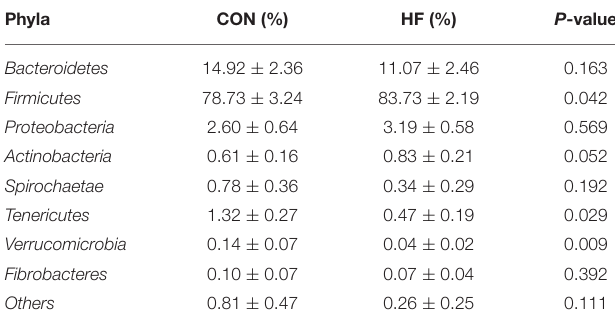
TABLE 6 | Effects of honeycomb flavonoids (0.5% of HF) on the relative abundances of cecal bacterial communities in the level of phyla ( n = 8).